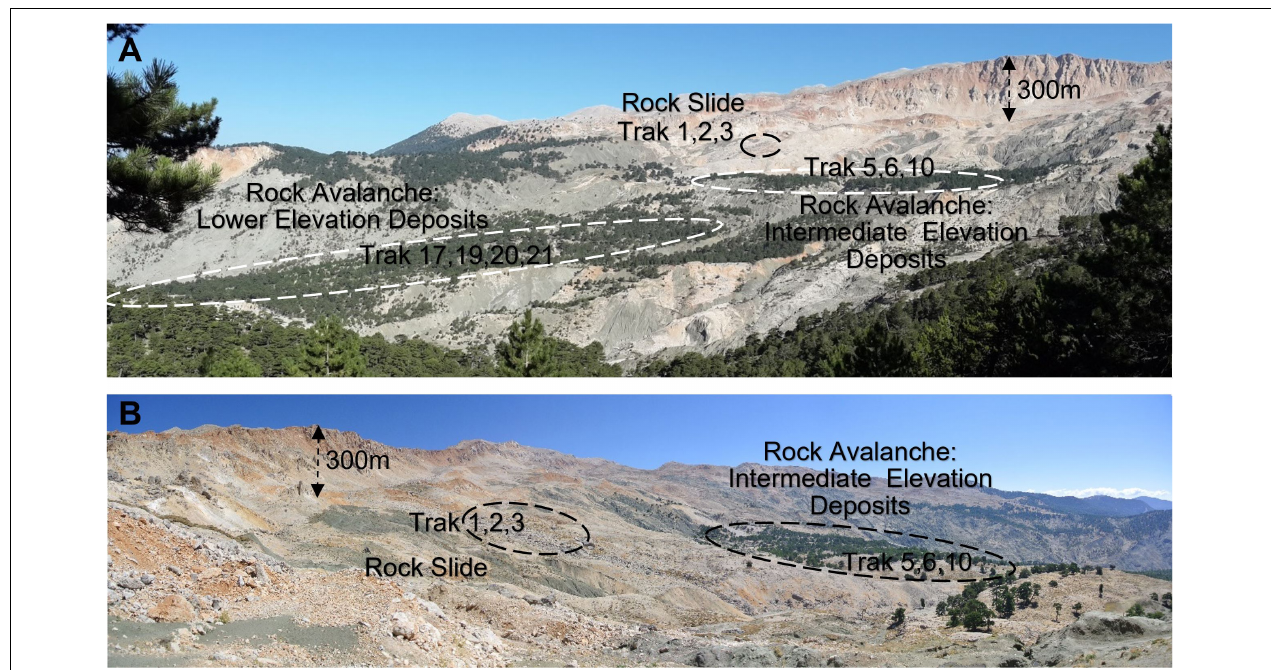
FIGURE 7 | Sampling sites for 36 Cl cosmogenic nuclide dating in the landslide complex. In Figure 4 , viewpoints of photographs are marked. (A) Rock avalanche and rockslide. (B) Higher elevation deposits of rock avalanche and